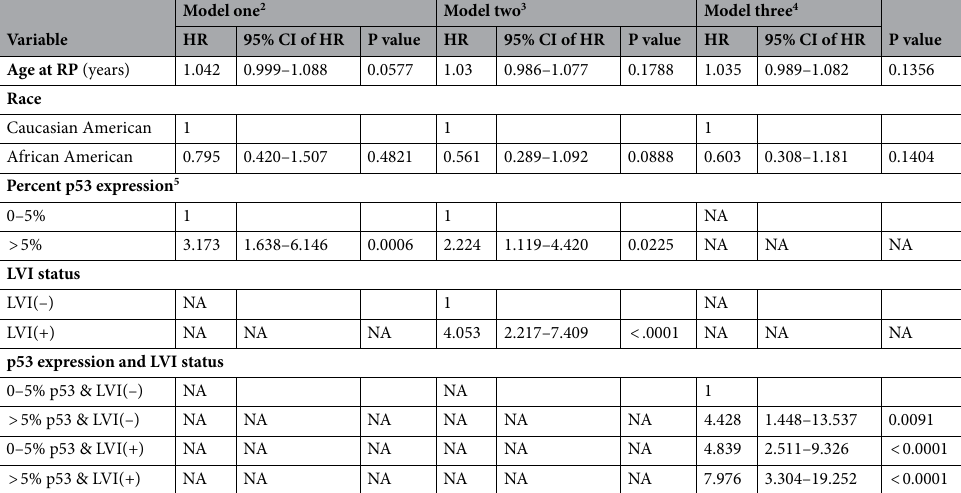
Table 3. Multivariable cox proportional hazards analysis predicting distant metastasis-free survival 1 .